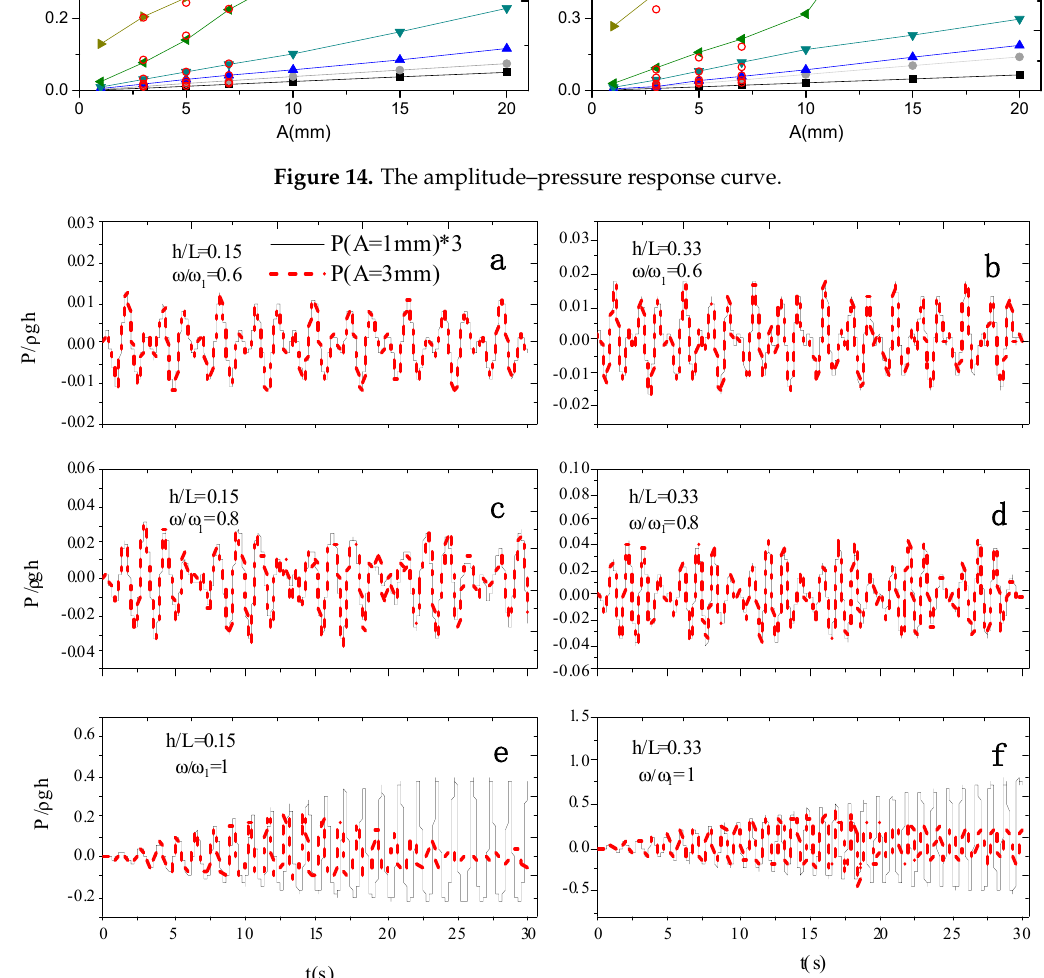
Figure 15. The comparison of pressure-time history curves at different amplitudes. ( a ) h/L = 0.15, ω = 0.6 ω 1 , ( b ) h/L = 0.33, ω = 0.6 ω 1 , ( c ) h/L = 0.15, ω = 0.8 ω 1 , ( d ) h/L = 0.33, ω = 0.8 ω 1 , ( e ) h/L = 0.15, ω = ω 1 , ( f ) h/L = 0.33, ω = ω 1 .